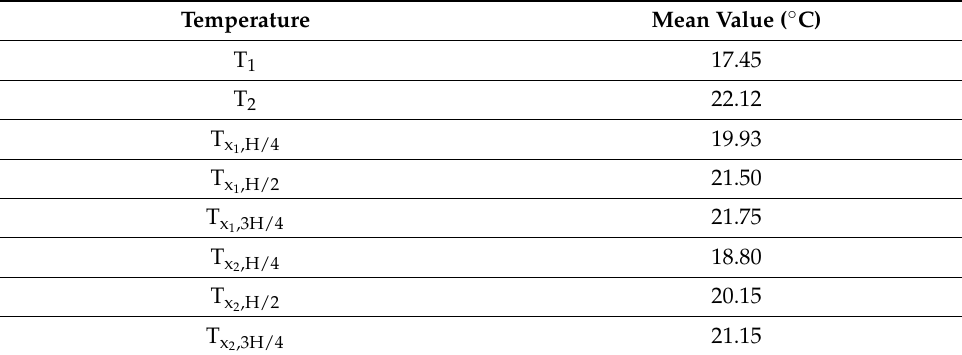
Table 2. Measured temperatures in wells 1 (x 1 ) and 2 (x 2 ).